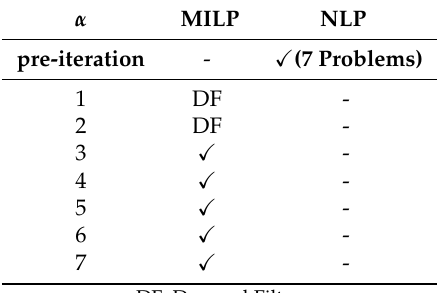
Table 11. Alpha iterations: Scenario 1 (MILP:mixed-integer linear programming; NLP: nonlinear programming).